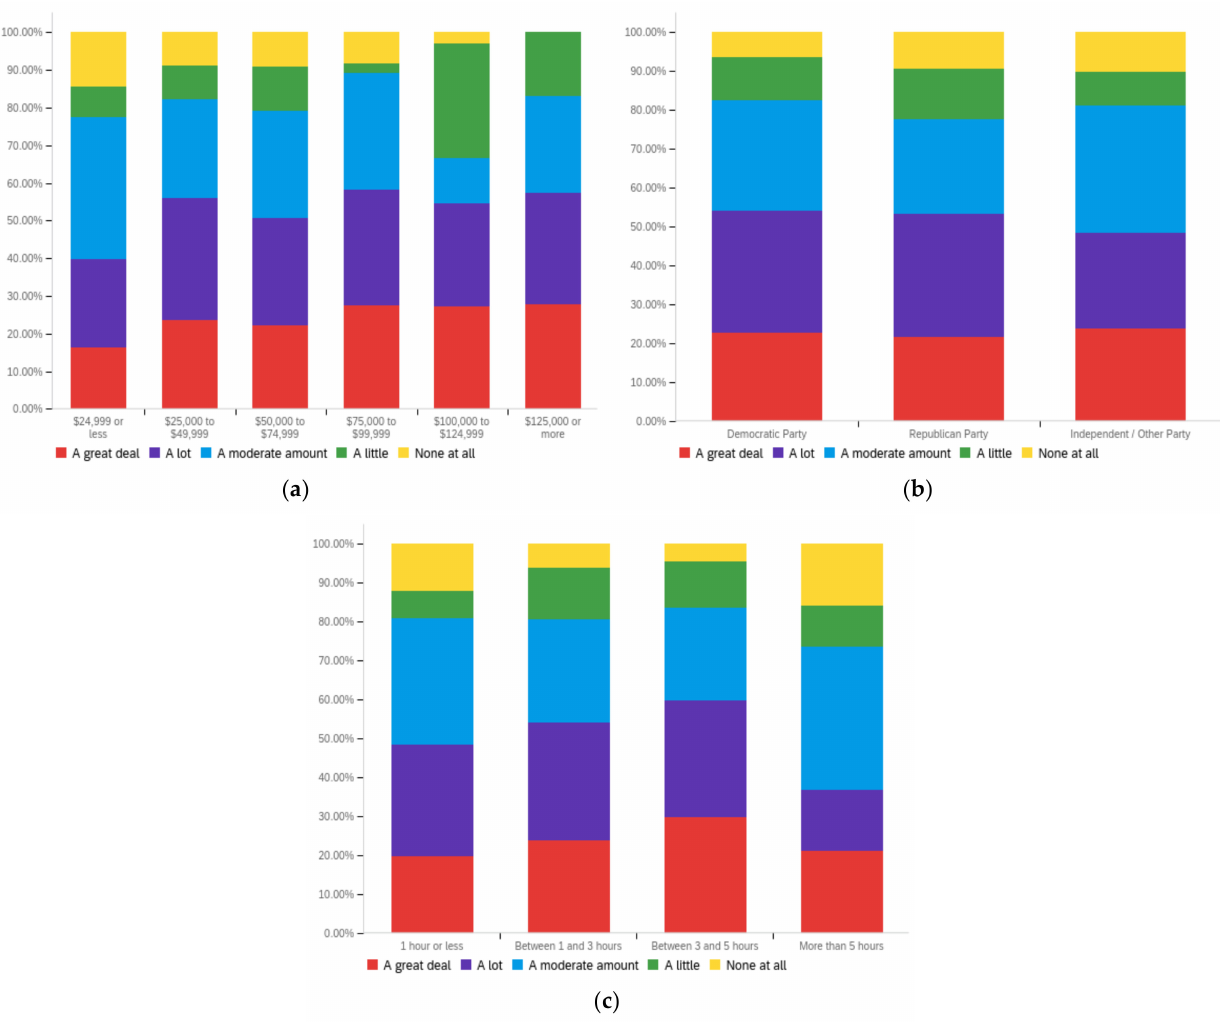
Figure A20. Article publisher’s political alignment—others’ perception impact by: ( a ) income level (top left), ( b ) political affiliation (top right) and ( c ) online usage